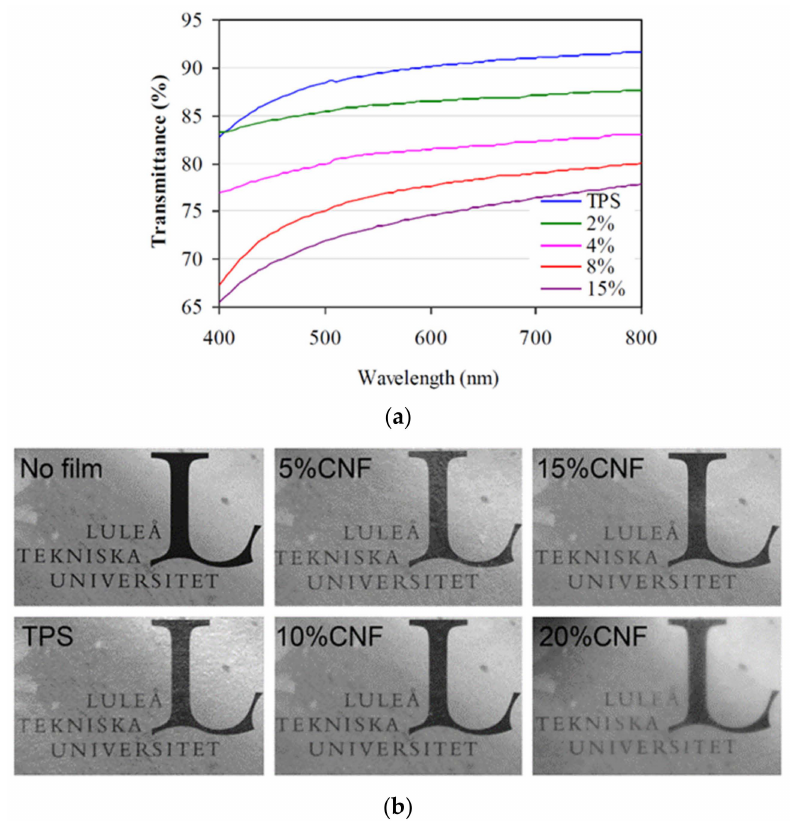
Figure 15. ( a ) UV-Vis transmittance spectra for TPS/CNF films. Reproduced with permission from Carbohydr. Polym. , 229, Fourati et al. One-Step Processing of Plasticized Starch/Cellulose Nanofibrils Nanocomposites via Twin-Screw Extrusion of Starch and Cellulose Fibers, 2020 [33]. ( b ) Visual aspect and transparency for TPS/CNF films at different wt %. Reproduced with permission from manufactured using twin-screw extrusion, 950–956, 2013